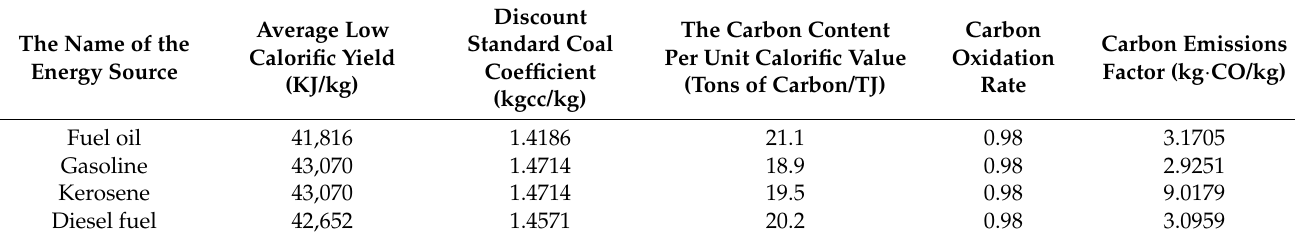
Table 3. CO 2 emission factors for different fuel types.